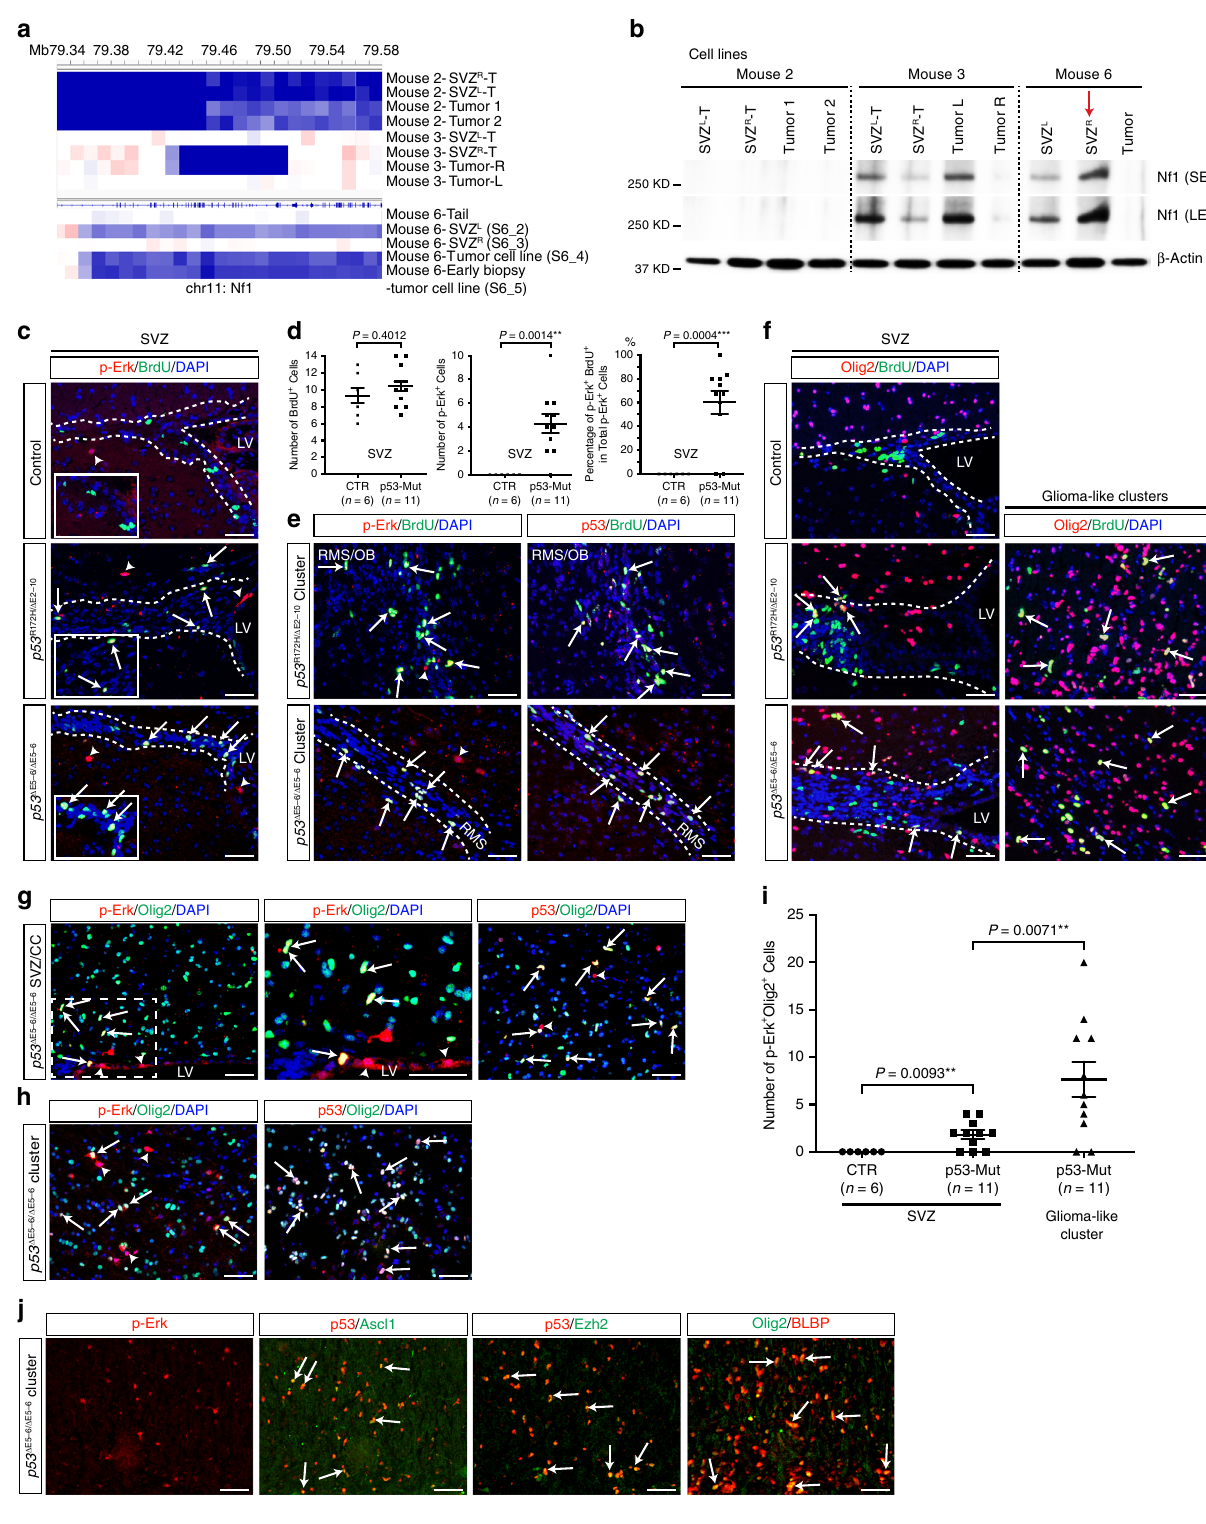
chr19-normal versus Pten /chr19 loss (or Pik3ca H1047R mutation), and associated low versus high levels of PI3K/Akt/mTORC sig- naling; (3) the relatively quiescent versus high proliferative state of glioma cells; and (4) the localization of tumors to the SVZ versus spatially segregated distant brain parenchyma. Together, these fi ndings suggest that the lack of a less proliferative “ early